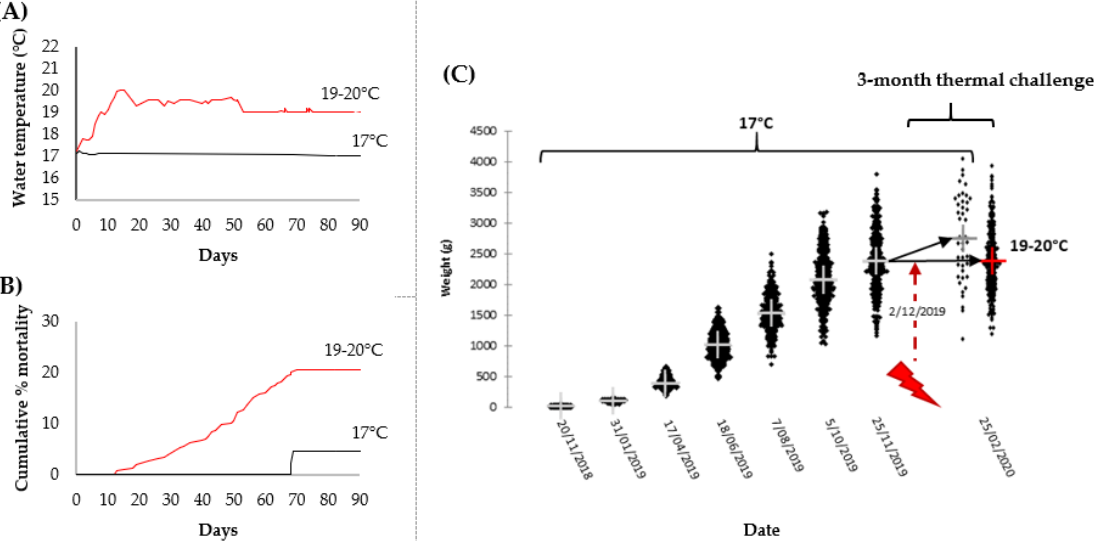
Figure 1. Effects of a chronic three-month thermal challenge (17 °C versus 19–20 °C) on Oncorhynchus tshawytscha performance. ( A ) Water temperature data for the thermal regimes (plotted as daily averages); ( B ) cumulative percent mortality during the challenge period; ( C ) total bodyweight of fish over the preceding one year of grow-out at 17 °C, and in the two temperature treatment groups on completion of the trial (individual fish are shown as dots with crosses representing their group means); the red lightning symbol indicates initiation of the thermal ramping to 19–20 °C in the temperature-chal- lenged group.